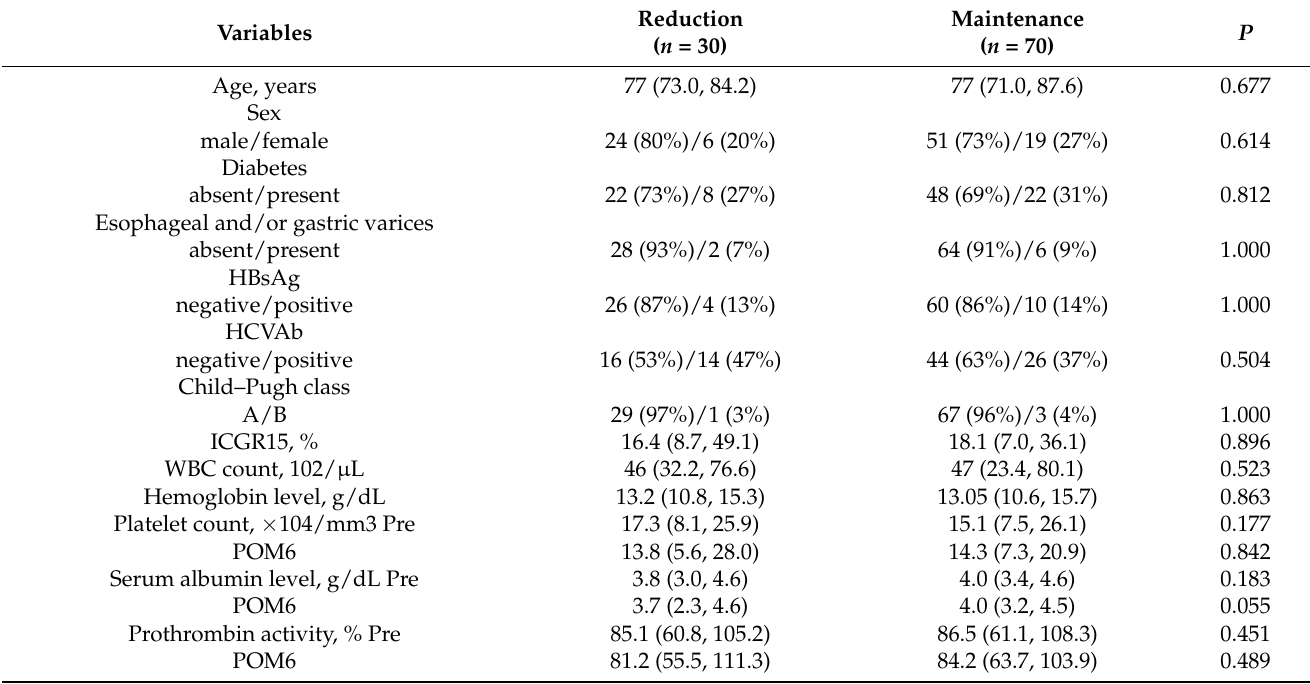
Table 3. Perioperative characteristics of HCC patients aged ≥ 70 years stratified according to G8 score change.